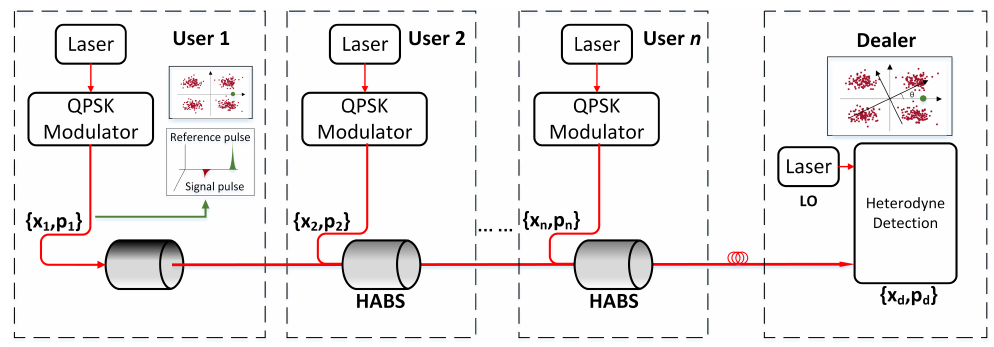
Figure 1. The LLO-based QSS with discretely modulated coherent